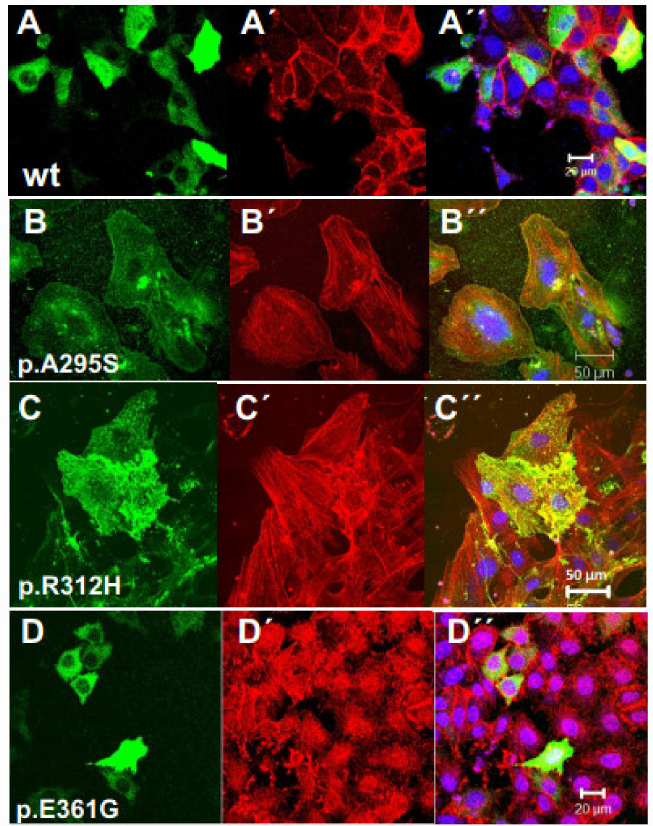
Figure 4. Transfection of Hela cells with EGFP-tagged c-actin variants. ( A – D ) EGFP-fluorescence, ( A’ – D’ ) TRITC-phalloidin staining, and ( A” – D” ) merged images together with Hoechst 33342 staining. ( A ) Wild type (wt) c-actin; ( B ) p.A295S mutant; ( C ) p.R312H mutant; ( D ) p.E361G mutant. For details, see text. Bars: ( A , D ): 20 µ m; ( B , C ): 50 µ